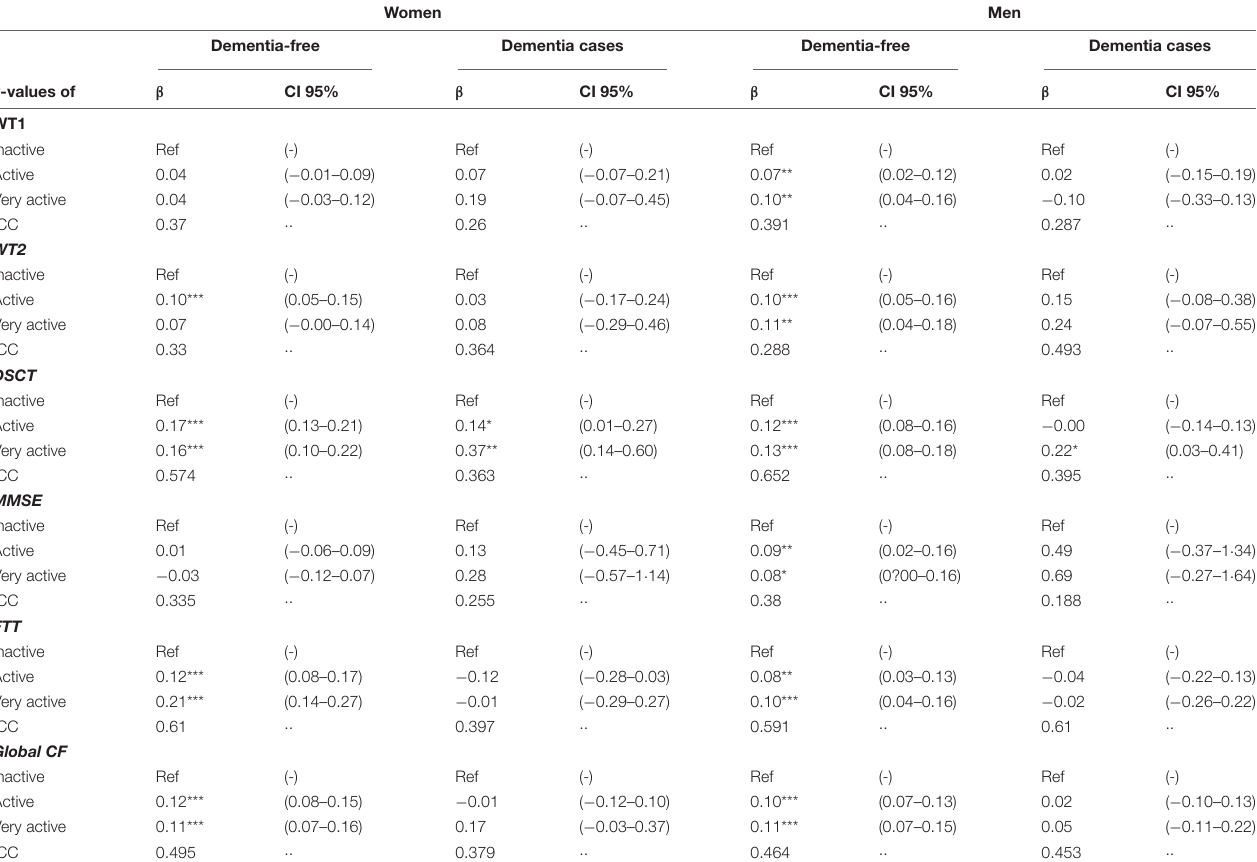
TABLE 3 | Mixed linear regression of activity impact on cognition with covariates. Women Men Dementia-free Dementia cases Dementia-free Dementia